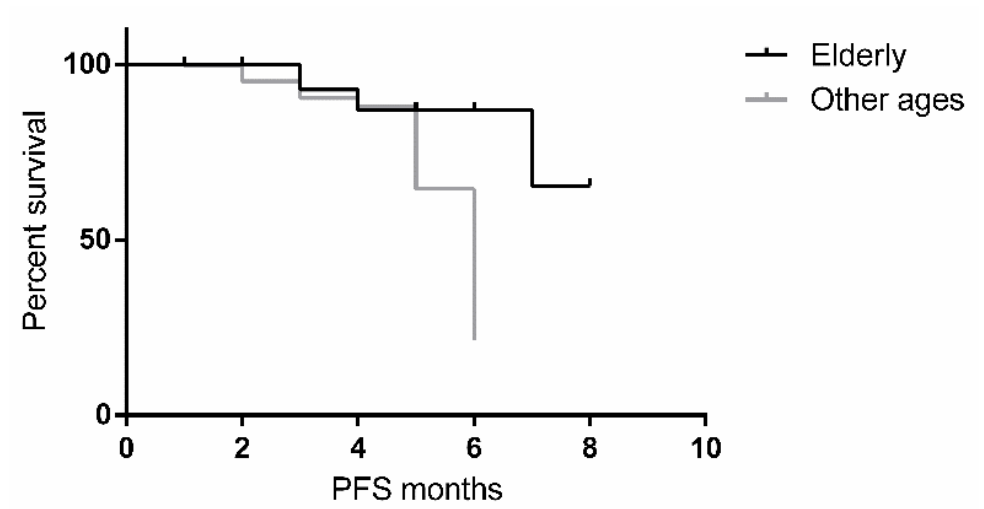
Figure 4. Kaplan-Meier curve showing the comparison of progression free survival (PFS) in patients of other ages and elderly.